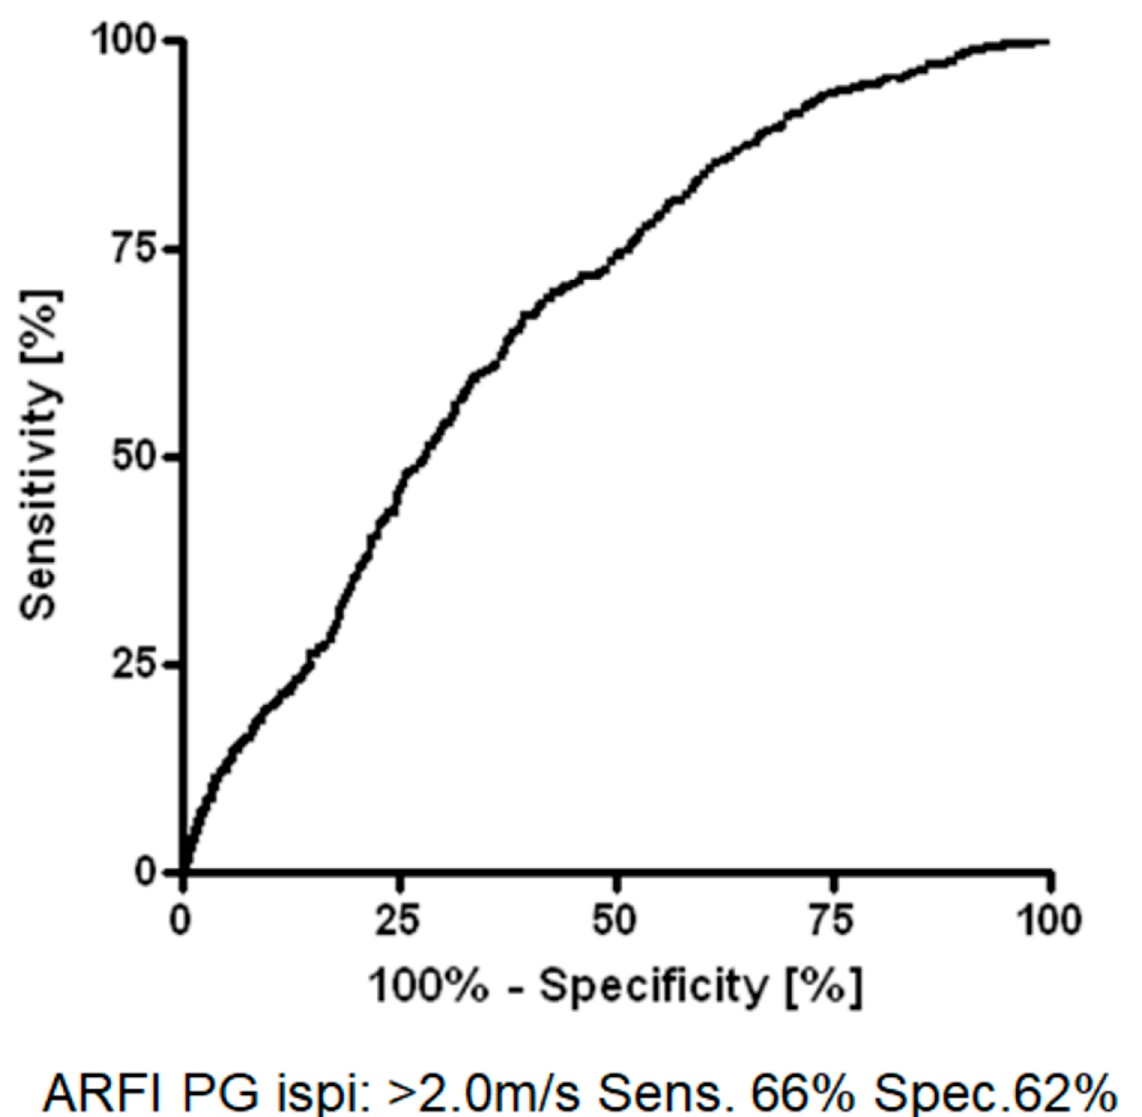
Figure 3. Receiver operating characteristic (ROC)-analysis and Youden test of shear wave velocity within the ipsilateral parotid glands (PG).